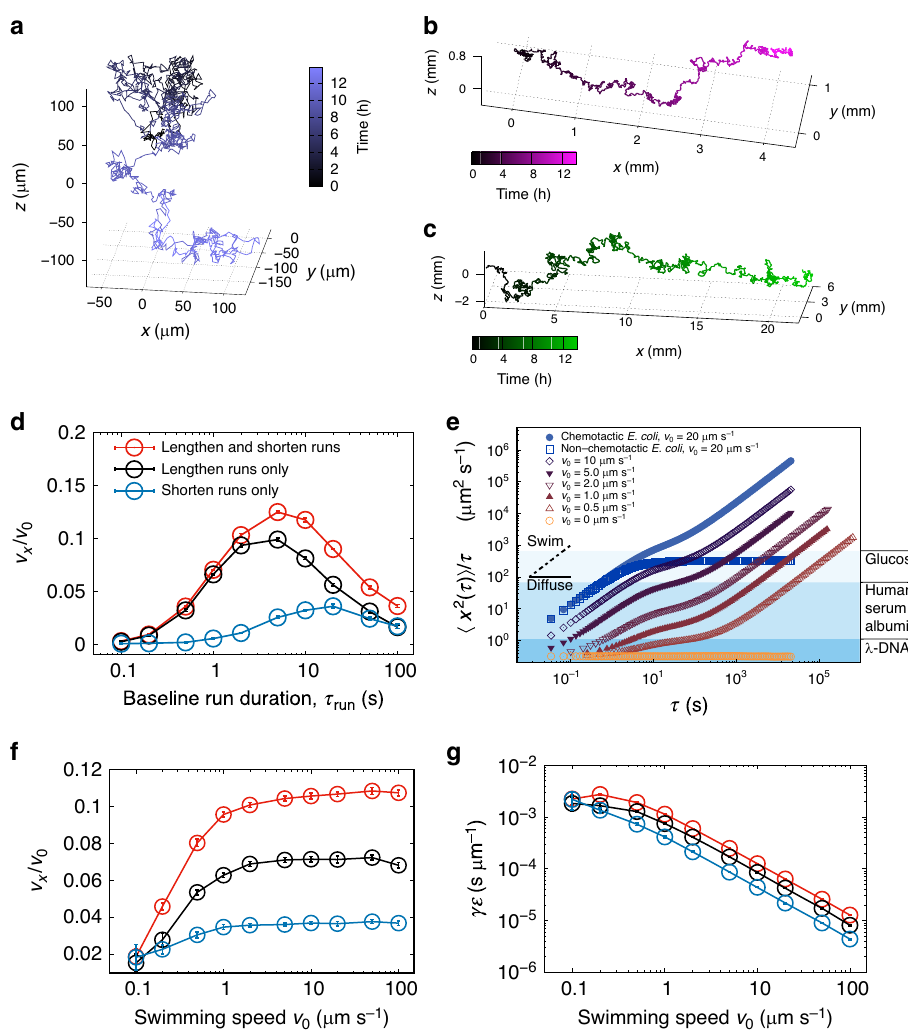
Fig. 5 Brownian dynamics simulations demonstrating chemotactic performance. a – c Simulated trajectories of a non-motile cell, a Haloferax sp. Boulby Mine (HXBM) cell, and an E. coli cell (respectively) in a chemical gradient. d Effects of modulating τ run for chemotactic strategies as indicated. Drift speed increases until τ run ~ 10 s for bipolar and run-lengthening modes. In run-shortening mode, the optimal run duration is around τ run ~ 20 s. Error bars represent s.e.m. (standard error of the mean). e Mean-squared displacements per unit time for simulated cells. Series represent HXBM unless otherwise indicated. Molecular diffusivities are given to the right, for comparison. S.e.m. is <0.02% of the values for all but the purely diffusive case and so have been omitted. f Fractional chemotactic drift speed of HXBM. The fractional drift speed increases at low v 0 before saturating at around v x ≈ 0.1 v 0 . Error bars represent s.e.m., and the series are coloured according to the swimming modes as in panel d . g Swimming ef fi ciency ( ε ) multiplied by the friction coef fi cient ( γ ), showing a broad decline in ef fi ciency at higher speeds, consistent with the results in panel f . Error bars represent s.e.m., and the series are coloured according to the swimming modes as in panel d